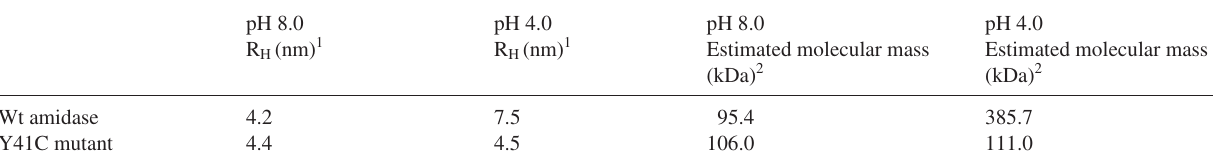
Table 2. Estimationof molecular mass by dynamic light scatteringmeasurementswith the wild type (wt) amidase and the Y41C mutant. Abbrevi- ation: R H = hydrodynamic